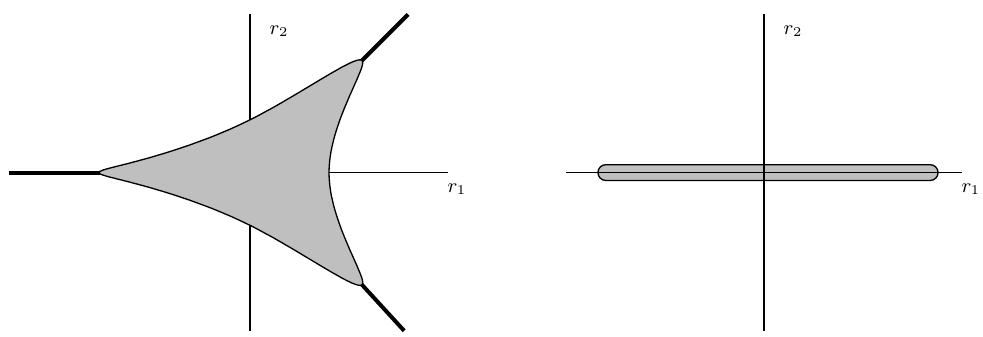
Figure 4 . Components of the discriminant. The mixed branch (right) gets lifted by the superpo-